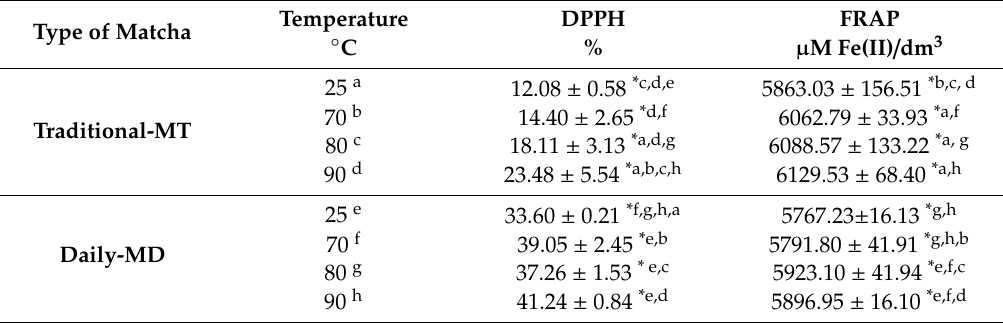
Table 1. Antioxidant potential (DPPH, FRAP) in Matcha tea infusion (Traditional, Daily).